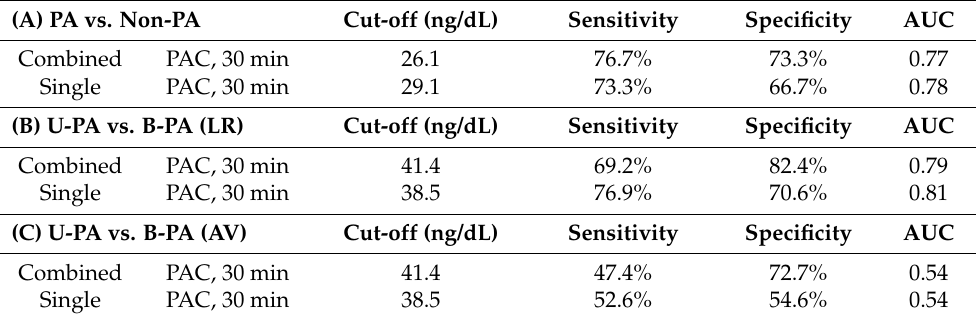
Table 3. ROC analysis of combined and single tests for detecting PA and PA subtypes in patients with PRA < 1.2 ng/mL/h a .